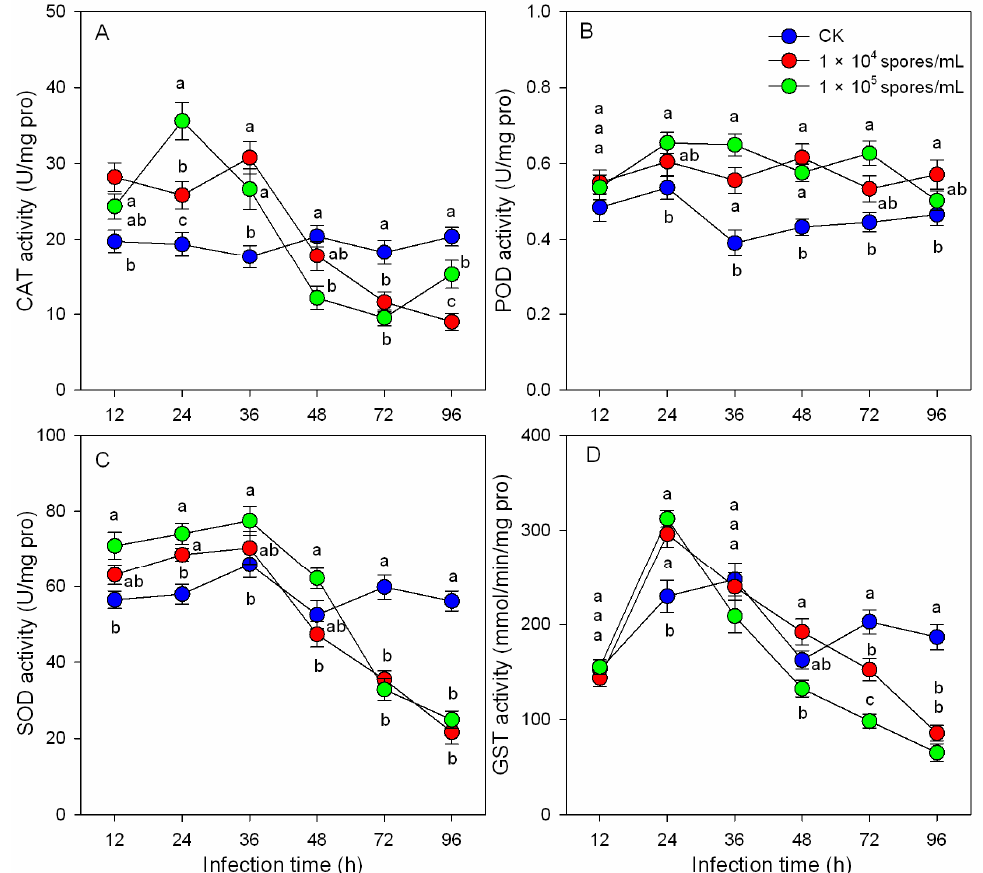
Figure 3. Antioxidant enzyme activities (( A ): CAT, ( B ): POD, ( C ): SOD, and ( D ): GST) of B. odoriphaga larvae after infection with M. hiemalis spores. Data in the figure are the mean ± SE. Different letters over the same column indicate significant differences between different spore concentration treatments at the p < 0.05 level by one-way ANOVA.